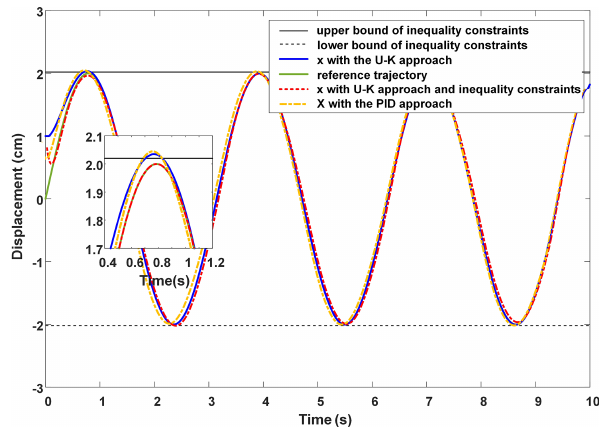
Figure 3. PMLM error under the step response. Figure 4. PMLM displacement under the sinusoid signal.